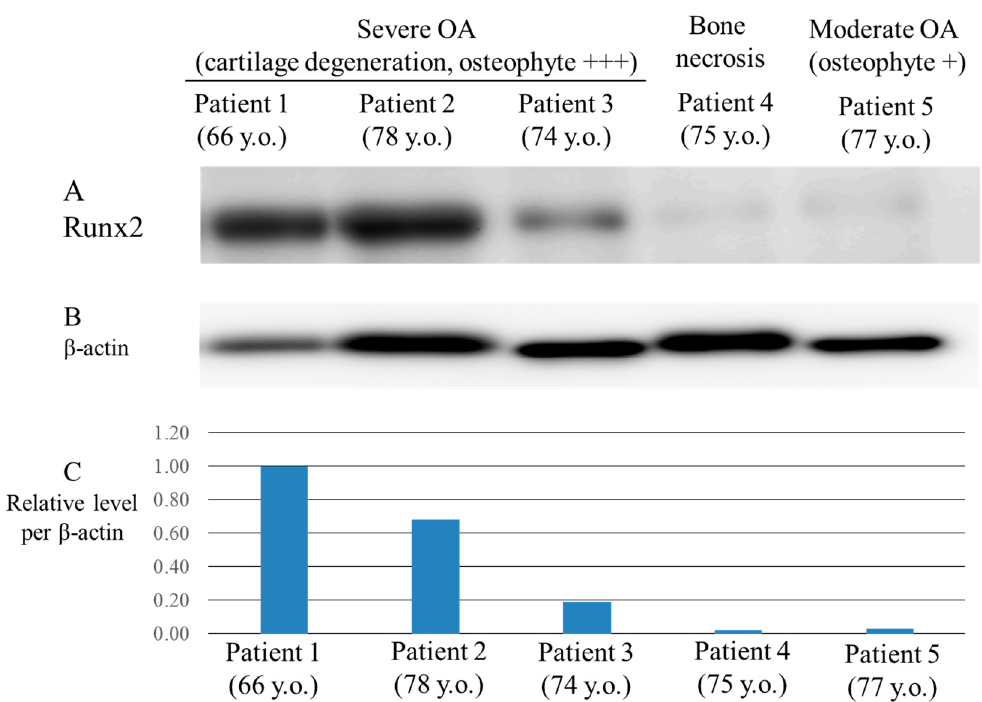
Figure 2. Expression of Runx2 in osteoarthritic chondrocytes from donors. ( A ) Expression of Runx2 in chondrocytes from patients with OA (Patient 1, 2, 3, 5) and from patient with idiopathic osteonecrosis of femoral condyle (Patient 4); ( B ) Expression of β -actin.; ( C ) Relative ratio against the level of expression of β -actin. The level of Runx2 expression was analyzed as a relative ratio against the level of expression of β -actin. Runx2 protein was strongly expressed in osteoarthritic chondrocytes from “Patient 1”, “Patient 2” and “Patient 3” in comparison with “Patient 4” and “Patient 5”.